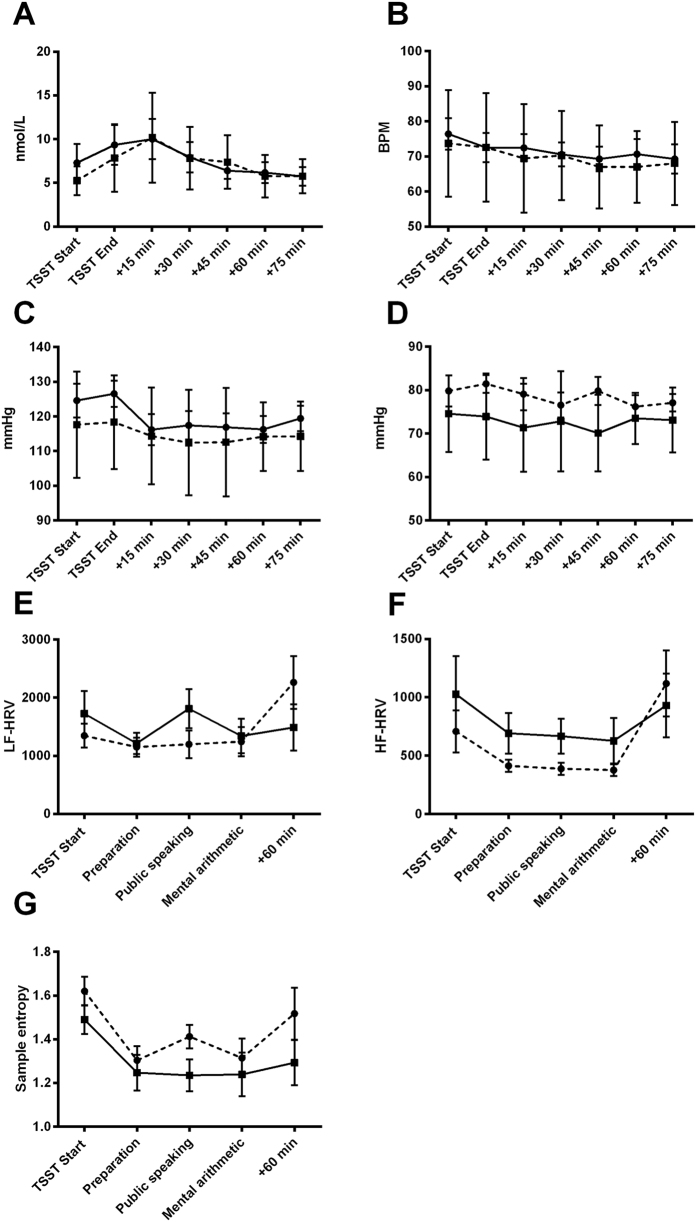
Neuroendocrine and autonomic response to the Trier Social Stress Test (TSST) in Indigenous and non-Indigenous participants.No significant between-group differences were observed in (A) cortisol, (B) heart rate, (C) systolic blood pressure, (D) diastolic blood pressure, (E) low-frequency heart rate variability, (F) high frequency heart rate variability or (G) sample entropy. Error bars are SEM.